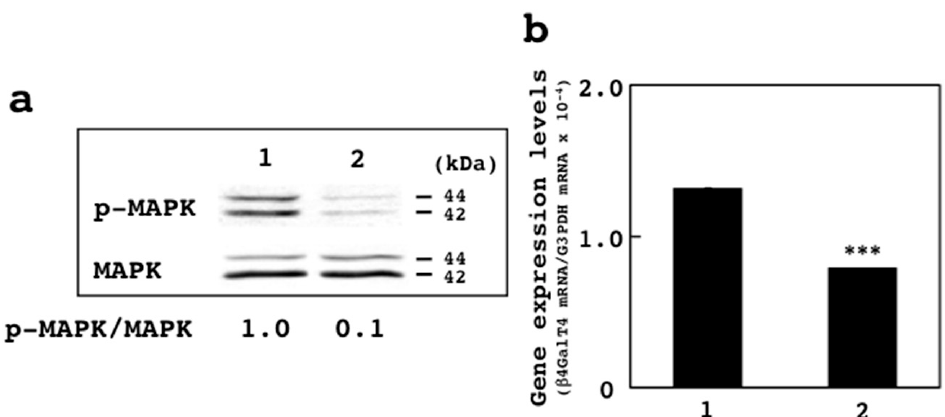
Figure 6. Effects of U0126 on the phosphorylation of MAPK and the expression of the β 4GalT4 gene. ( a ) Immunoblot analysis of the cell lysates from the DMSO- (lane 1) and U0126-treated sensor cells (lane 2). Blotted filters were incubated with anti-p44/42 MAPK and anti-phospho-p44/42 MAPK (T202Y204) antibodies. The ratio of amounts of phosphorylated MAPK against MAPK between the DMSO- and U0126-treated cells is shown at the bottom of the blots. ( b ) Comparison of the expression levels of the β 4GalT4 gene between the DMSO- (1) and U0126-treated SW480 cells (2). Data show means ± S.D. ***, p < 0.001 against control.